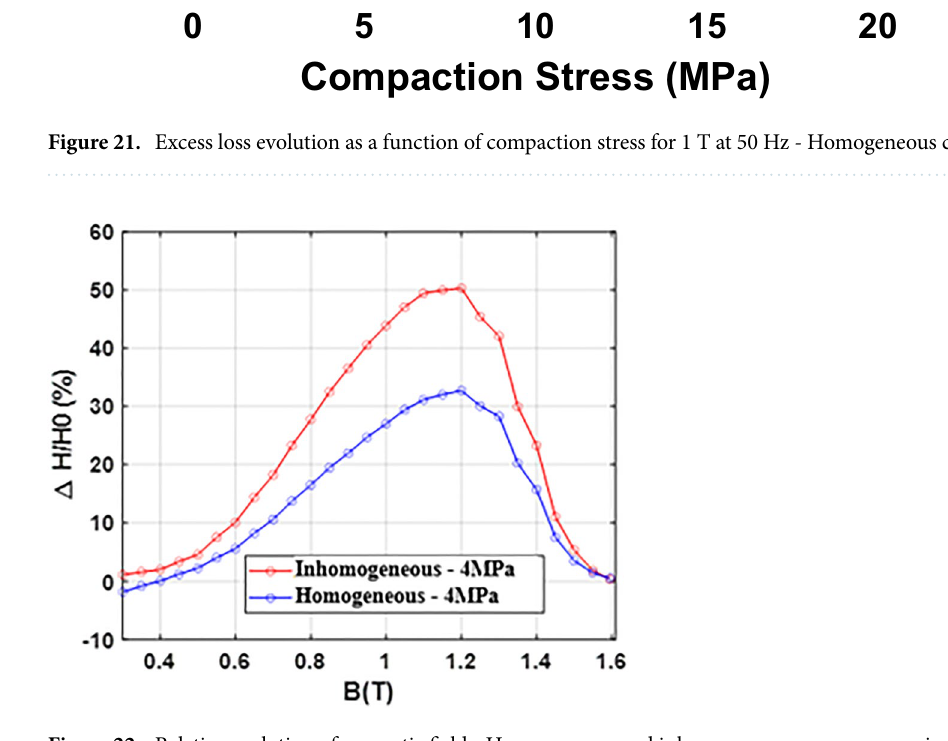
Figure 22. Relative evolution of magnetic field - Homogeneous and inhomogeneous cases